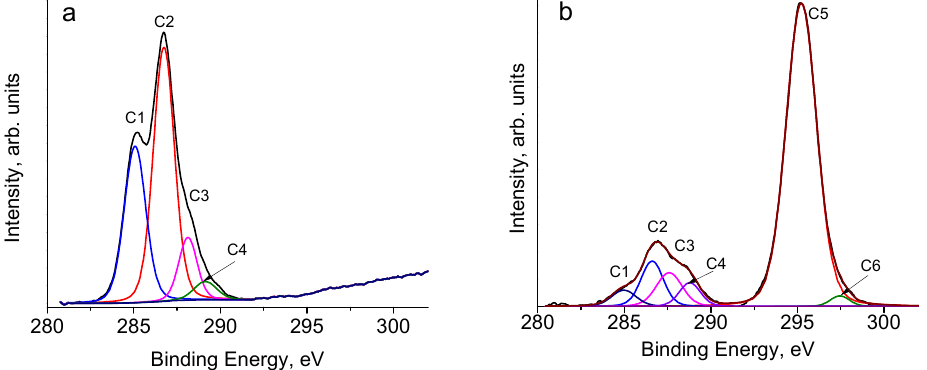
Figure 7. XPS spectra of HogC film before ( a ) and after ( b ) telomer treatment. After treatment with a telomere solution, the most intense peak in the spectrum of the film was the peak due to carbon atoms of the CF 2 groups (Figure 7, Table 8). We also noted here that the decomposition gave rise to the C6 peak, which could be attributed to end groups. The C5/C6 ratio can estimate the average number of tetrafluoroethylene molecules that participated in telomer formation [43]. Finally, from the data presented in Table 8, it followed that the layer analyzed by the XPS method consisted of almost 80% telomer molecules, which explained the reason for the hydrophobicity of the surface of the HogC film after this treatment. Table 8. Relative peak areas (in %) from deconvoluted C 1s spectra.